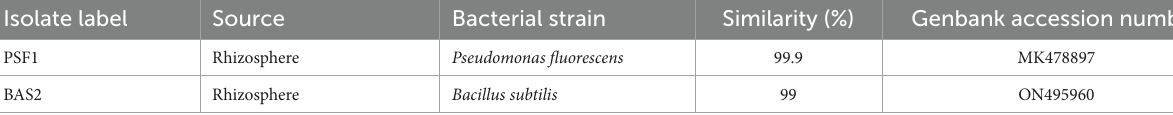
TABLE 2 Identity of rhizobacterial isolates based on 16S rRNA gene sequence. Isolate